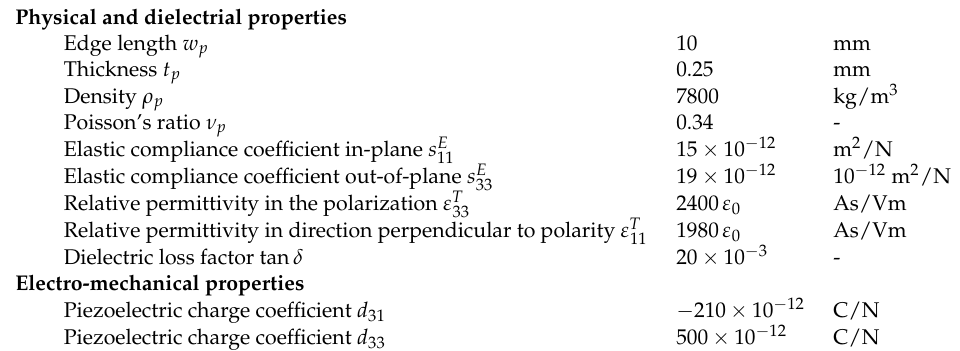
Table 1. Properties of PWAS (material: PIC151) according to supplier [34]. Physical and dielectrial